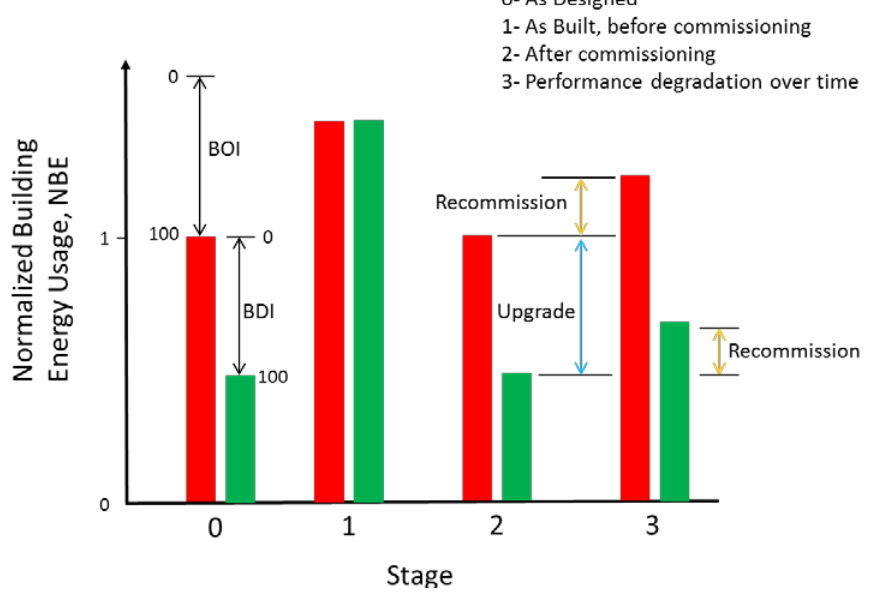
Figure 2. Normalized building energy usage at various stages of a building’s life.